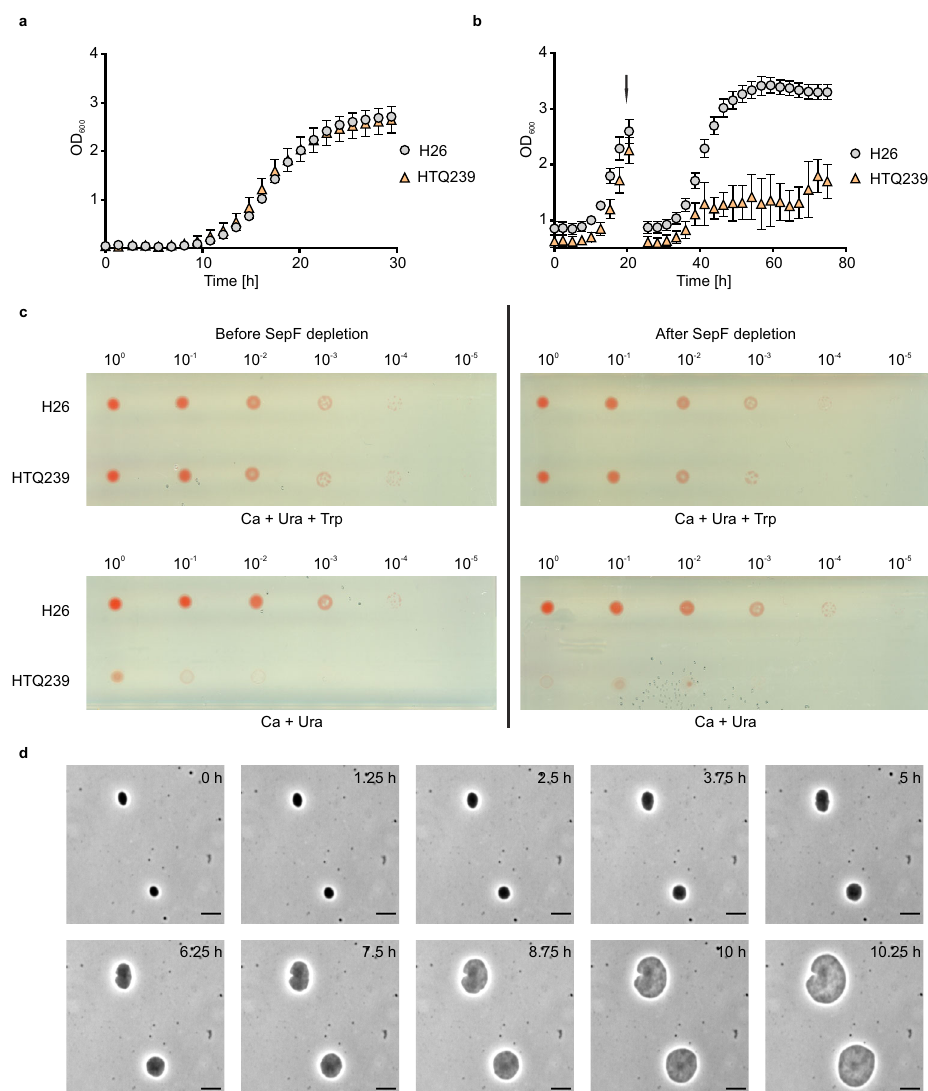
Fig. 4 Growth of H26 and HTQ239 in the presence and absence of tryptophan. a Growth curve of H26 (gray) and SepF depletion strain HTQ239 (orange) grown in CAB-medium supplemented with tryptophan and uracil. b Growth curve of H26 (gray) and HTQ239 (orange) after dilution in CAB- medium without tryptophan (indicated by the arrow). After the transfer, HTQ239 stopped growing while H26 grew unaffected. The data for these growth curves were acquired from four independent cultures per strain. Error bars indicate the standard deviation. c Spot survival assay of H26 and HTQ239. In the left panel, cells were cultured under non-SepF depleting conditions before they were spotted on plates with or without tryptophan. On the right panel, cells were grown under depleting conditions before they were spotted on plates with or without tryptophan. Under both culturing conditions of the precultures, strain HTQ239 showed the same viability of H26 when grown on plates supplemented with tryptophan. In contrast, on plates without tryptophan the viability of strain HTQ239 dropped compared to H26. In total three technical replicates with three biological replicates per strain and pre-culture condition were performed. d Time-lapse microscopy of HTQ239 cells in the absence of tryptophan: Cells were grown on an agarose nutrition pad (without tryptophan) in a thermo-microscope set to 45 °C and imaged every 15 min. During imaging the cells strongly increased in size while they were not able to execute cell division. Exemplarily cells every 1.25 h after depletion are shown. The experiment was repeated three times independently with similar results. Scale bars: 4 µ